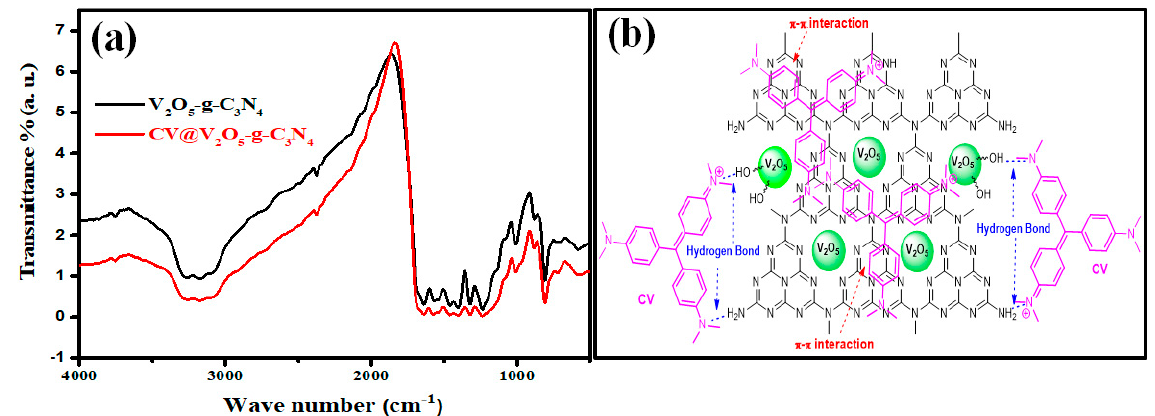
Figure 6. ( a ) FTIR spectra of CV@V 2 O 5 -g-C 3 N 4 and ( b ) proposed adsorption mechanism of CV onto V 2 O 5 -g-C 3 N 4 .